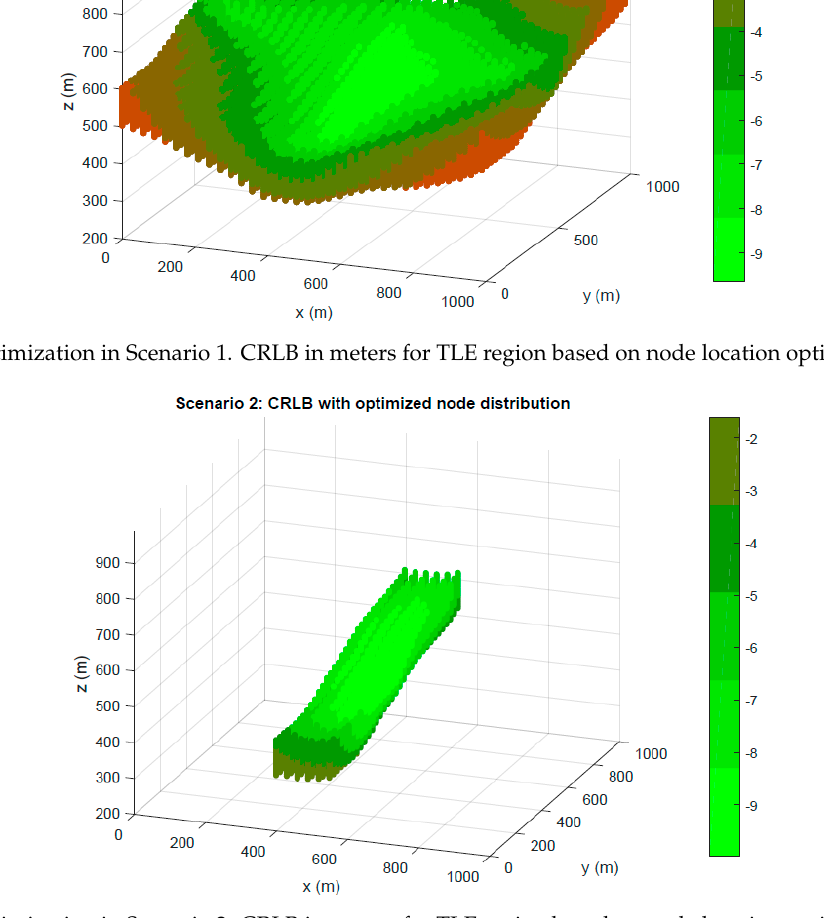
Figure 7. Optimization in Scenario 2. CRLB in meters for TLE region based on node location optimized by GA.